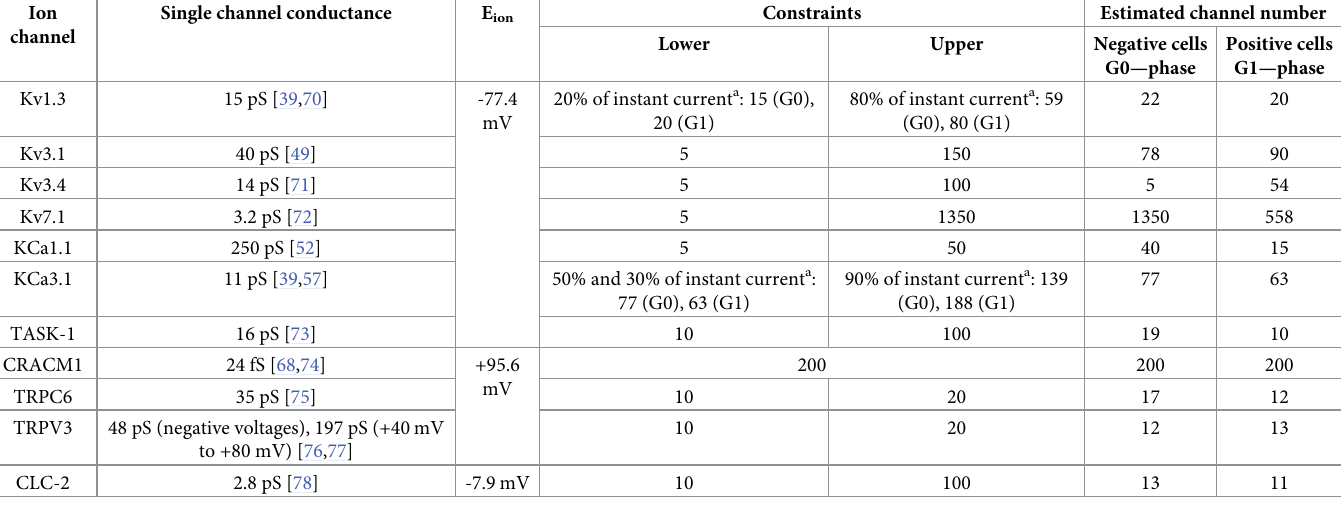
a) At voltage-level +40